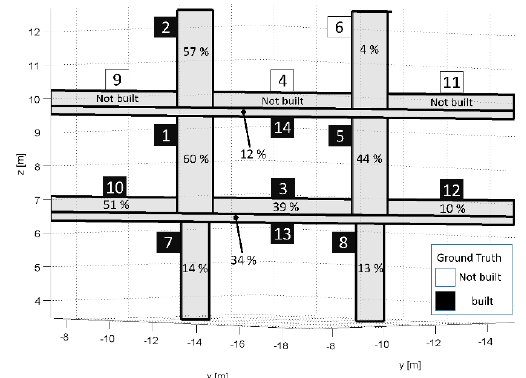
Figure 10. Results for 14 model planes with the states defined in Section 3.3 (Figure 4). Percentages are given for the state “possibly built with the percentage X of the area